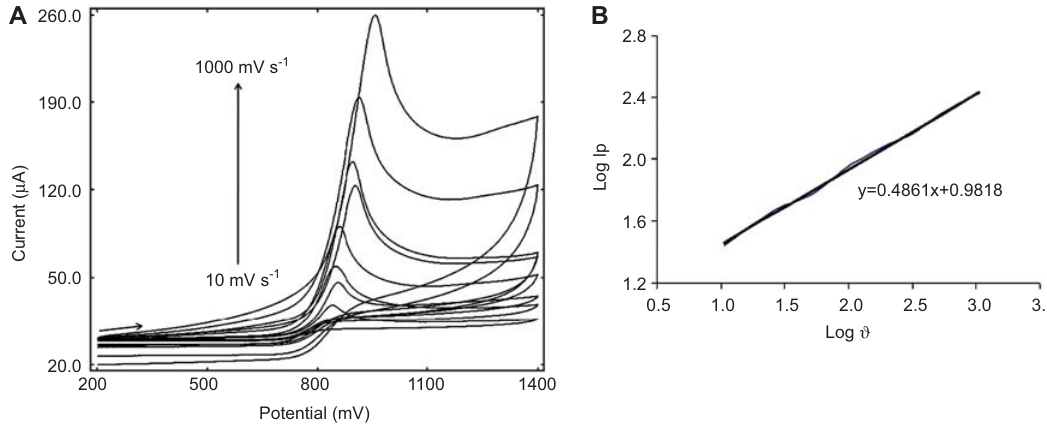
Figure 7 (A) Overlaying cyclic voltammograms of different scanning rate for 10, 25, 50, 100, 200, 300, 500, and 1000 mV s -1 and + 0.2 and + 1.4 V potential range; (B) plot of logarithm of peak current vs. logarithm of scan rate dependence of the cyclic voltammetric response at a modifi ed GC